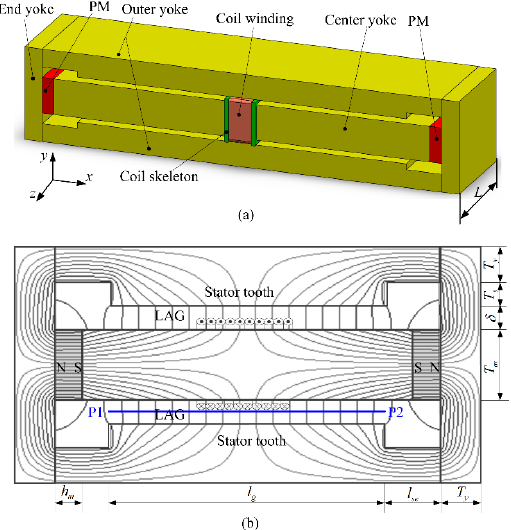
Figure 1. Schematic diagram of the rectangular closed double magnetic circuit (RCDMC): (a) 3D model; (b) 2D model, side view with magnetic flux lines. Reproduced with permission from [19], IEEE, 2019.